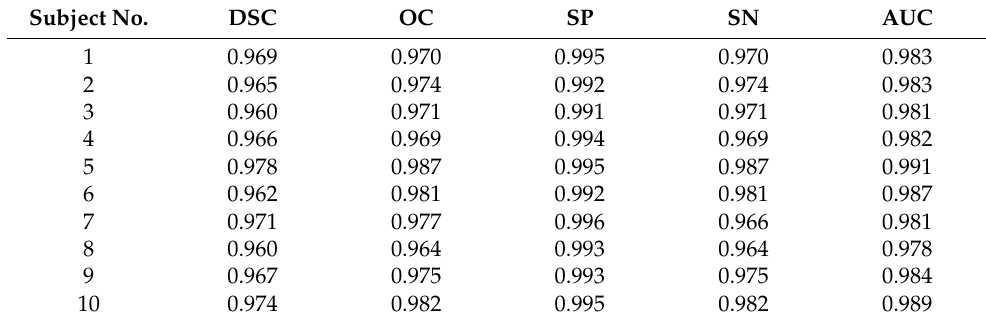
Table A5. Evaluation results for cerebellar tissue with fissures (model M2) on DLBS dataset.